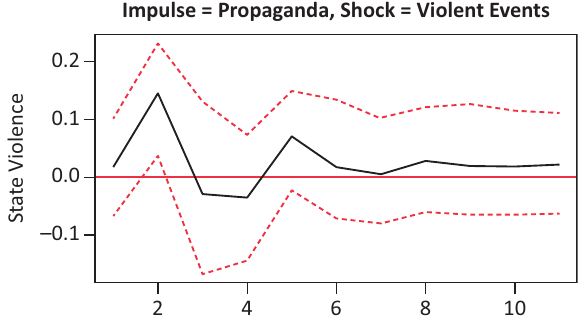
Figure 1. Impulse response function of propaganda on state violence,